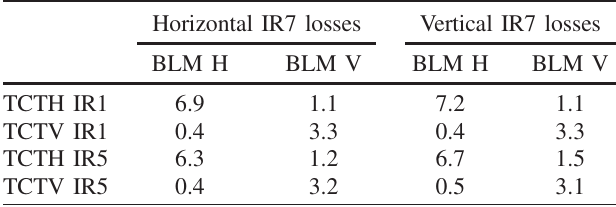
Fig. 14. As starting conditions we use the distribution of inelastic interactions in each collimator taken from the SixTrack simulation of the perfect machine. FLUKA simulations are done for both planes in B1. For each case, the TCTs in IR1 and IR5 are simulated in different runs.